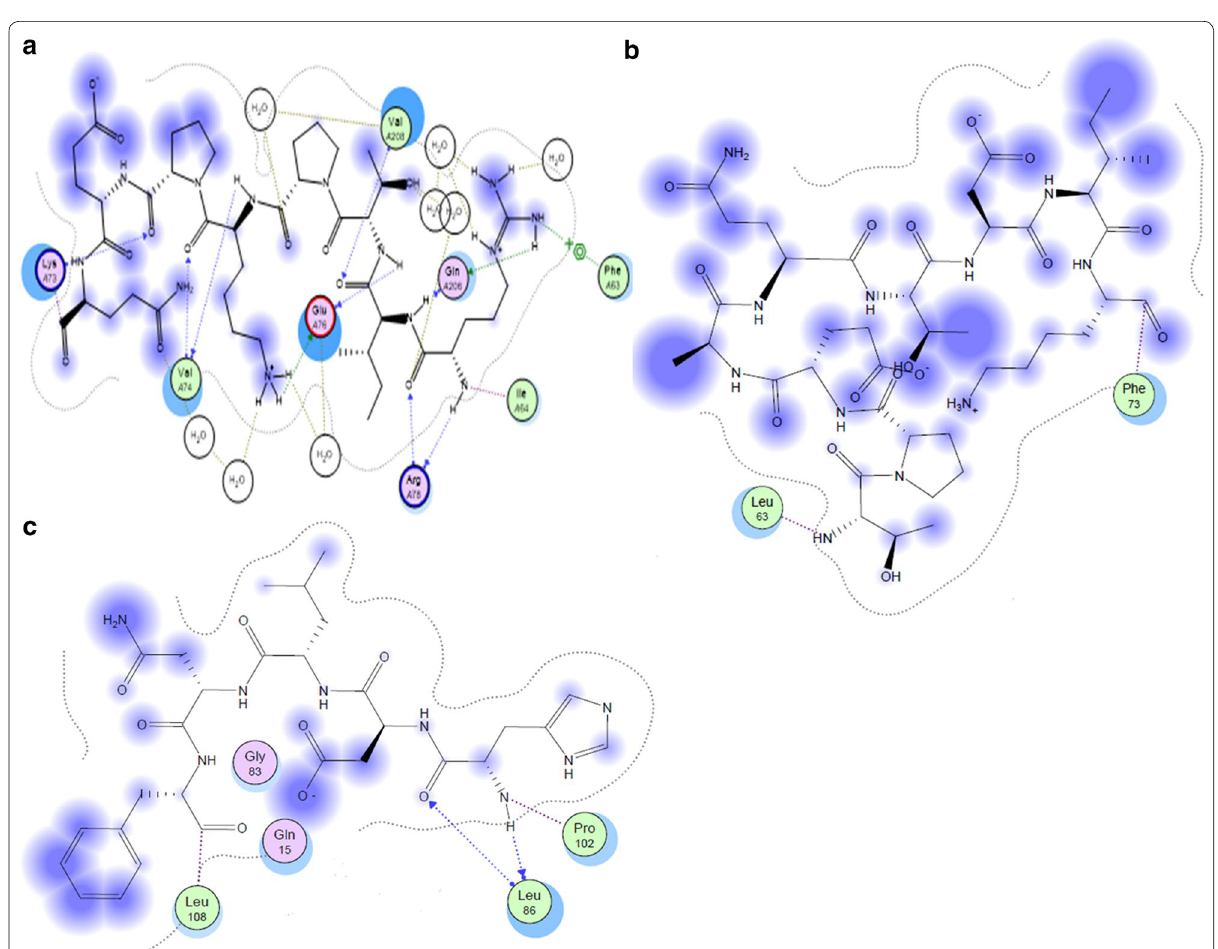
Fig. 6 Molecular docking of the compound pentanoic acid with anti-aging targets. a 2-D diagram of 1AH8 residues interacting with compound 3-methyl-4-oxo-pentanoic acid forming polar contacts with the ligands and residues showing in lines participating in other interactions. b 2-D diagram of 2KM1: protein binding interacting with compound 3-methyl-4-oxo-pentanoic acid. c 2L7E: transcription interacting with compound 3-methyl-4-oxo-pentanoic